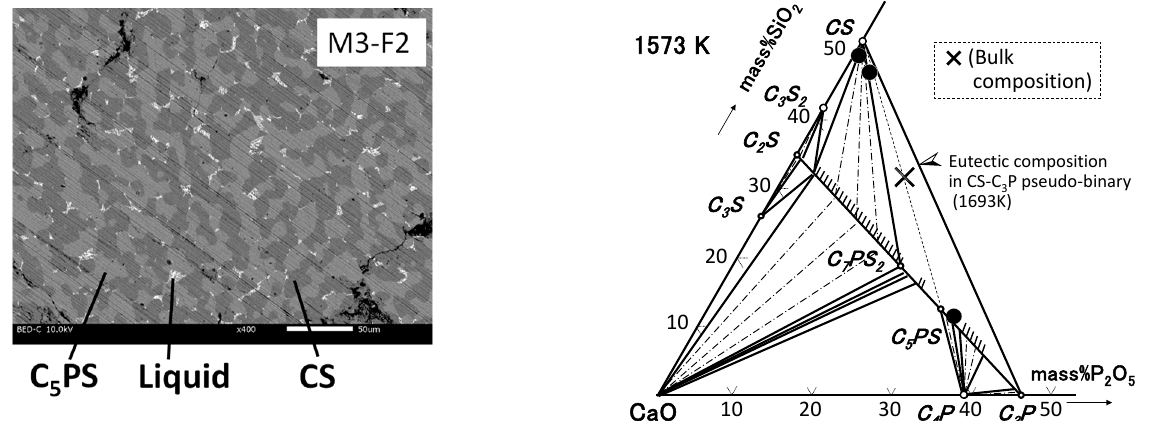
2 O 3 content with more